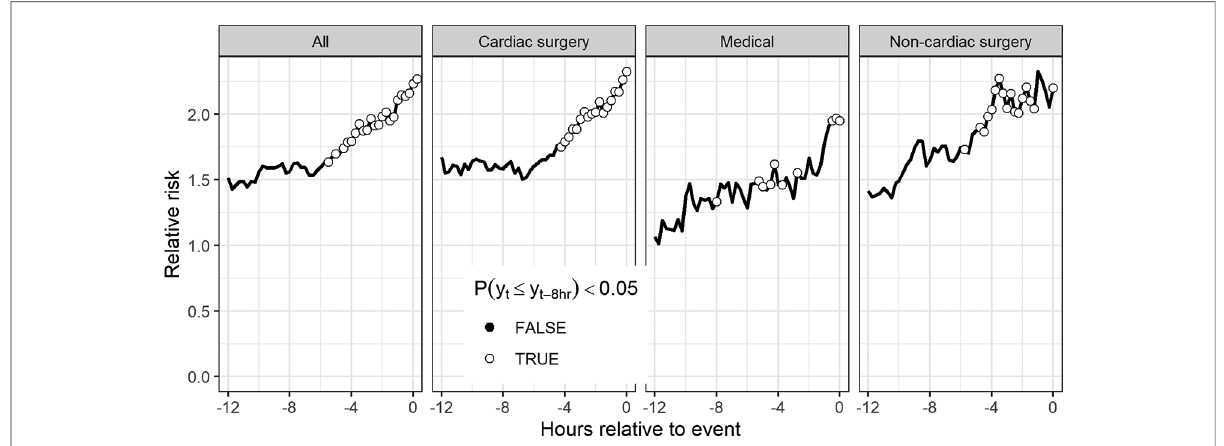
FIGURE 5 Average time series of model outputs leading up to the time of unplanned intubation. Results are cross-validated predictions from the model based on all patients and are shown for all patients as well as patients of each patient type. Open circles indicate risk estimates are signi fi cantly higher than risk estimates for the same patients 8 h prior based on a Wilcoxon signed rank